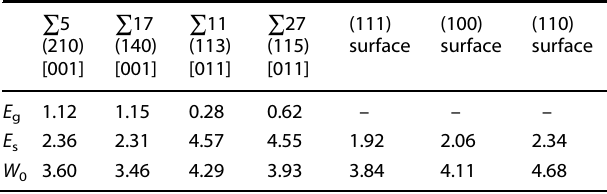
Table 4. GB energies, E g , surface energies, E s , and work of separation, W 0 (unit: J/m 2 )